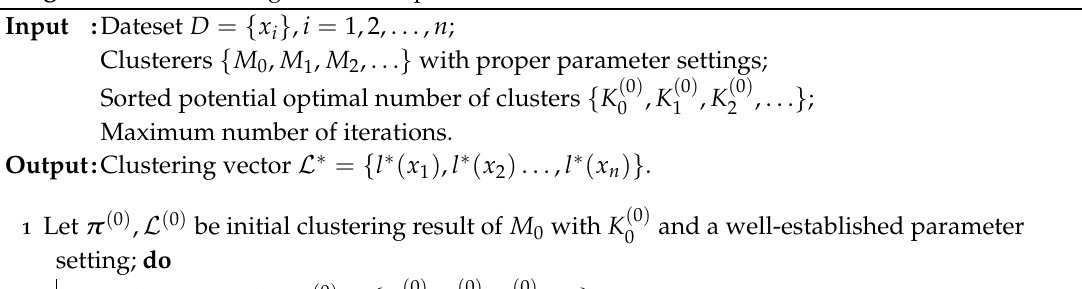
Algorithm 1: Clustering refinement